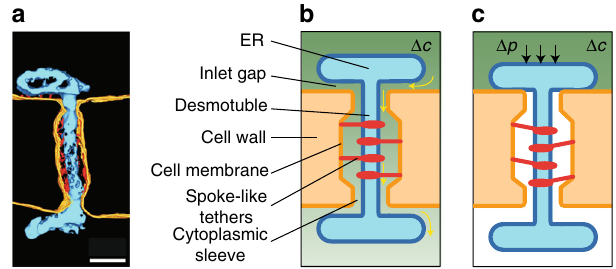
Fig. 1 Mechanosensitive plasma membrane (PM) nanopores. a TEM tomography of a PD highlighting the cell membrane (yellow lines), ER- desmotubule complex (blue) and spoke-like tether protein fi laments (red dots). Scale bar, 50 nm. b Schematic highlighting signi fi cant structural components and transport processes. Solute transport (yellow arrows) across the PD is driven by a concentration gradient Δ c (high concentration = dark green, low concentration = light green). c Mechanical effects on PD permeability: An intercellular turgor pressure difference Δ p leads to a displacement of the ER-desmotubule complex towards the cell wall, thus reducing the pore permeability. See details in the text. Panel a adapted